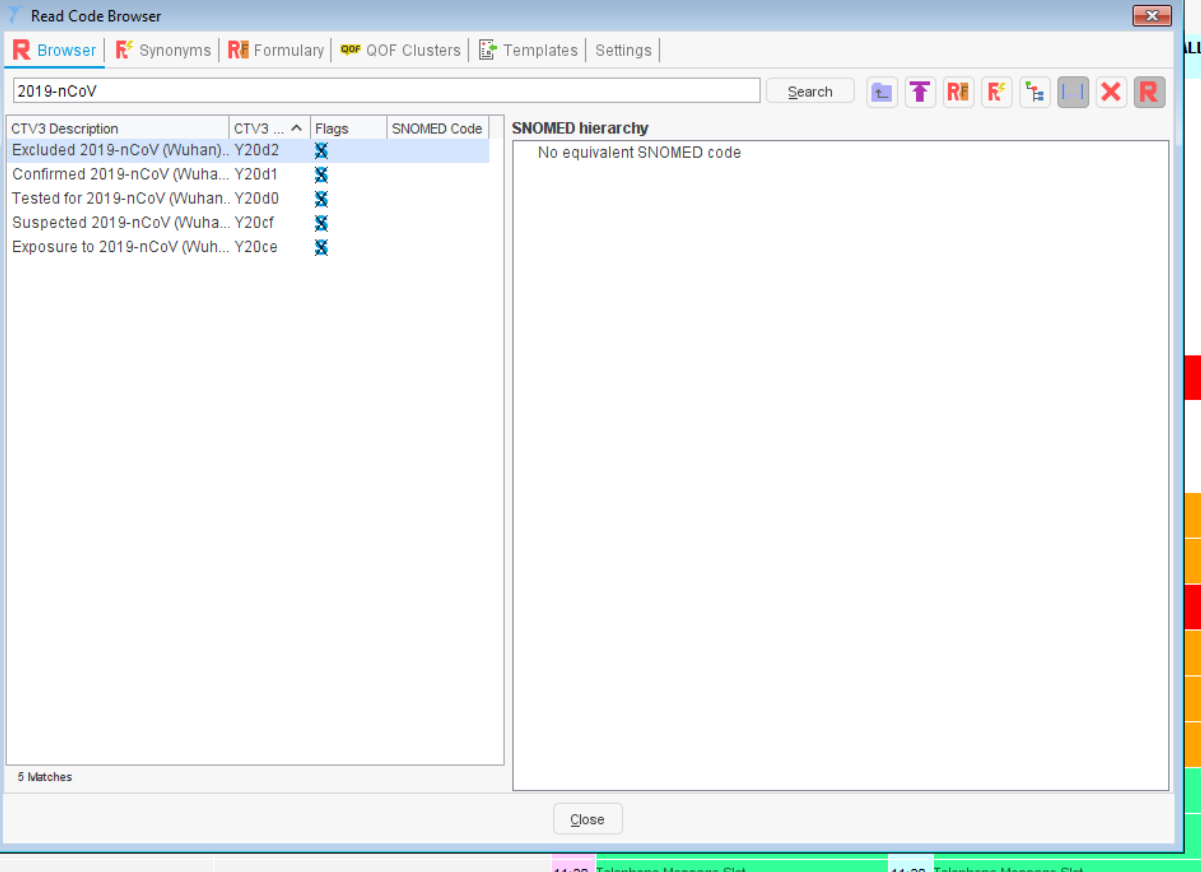
Figure 4. Screenshot of codes available in TPP SystemOne. SNOMED: Systematized Nomenclature of Human Medicine; 2019-nCoV: novel